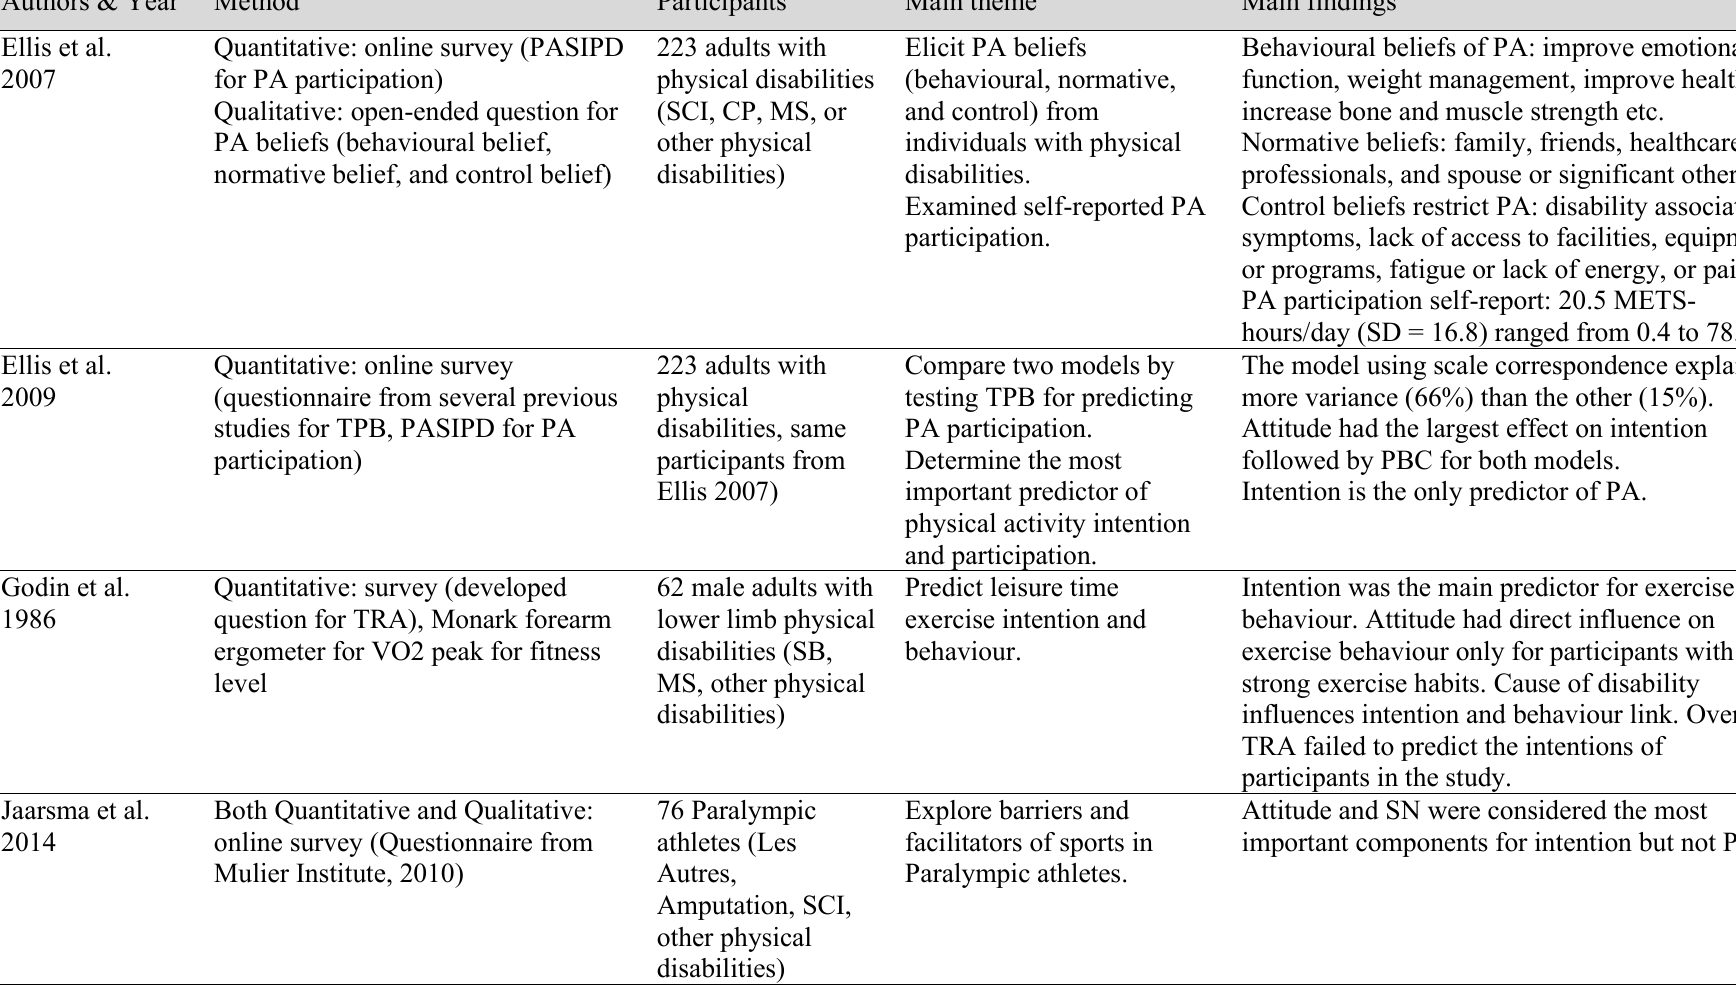
Table 1 . Descriptive information of included